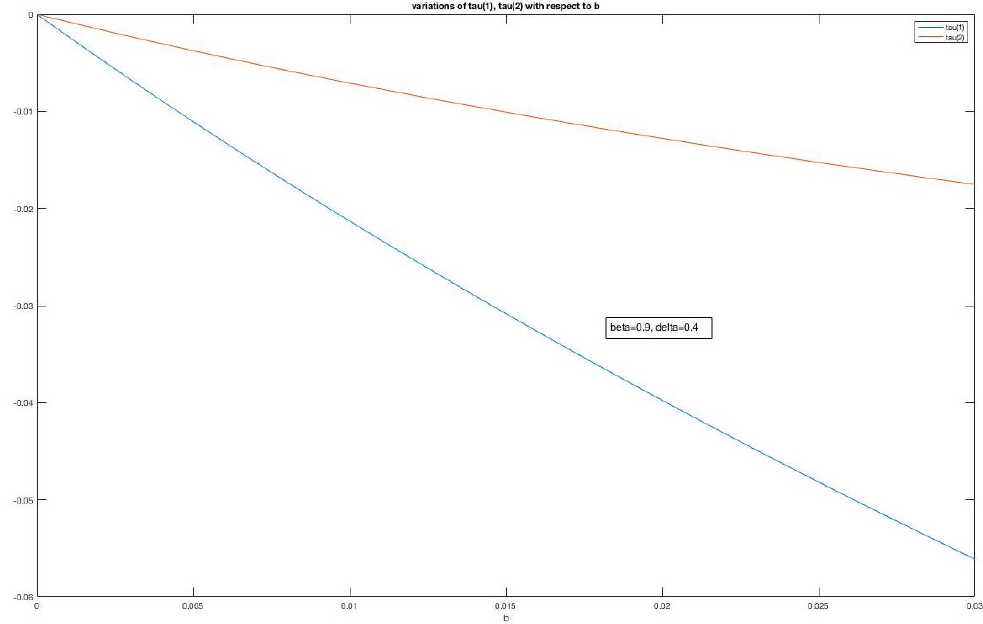
Figure 1. Effects of change of b on τ 1